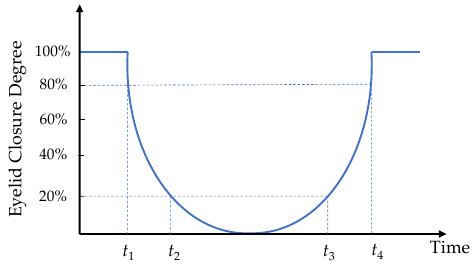
Figure 4. Schematic diagram of measuring PERCLOS.